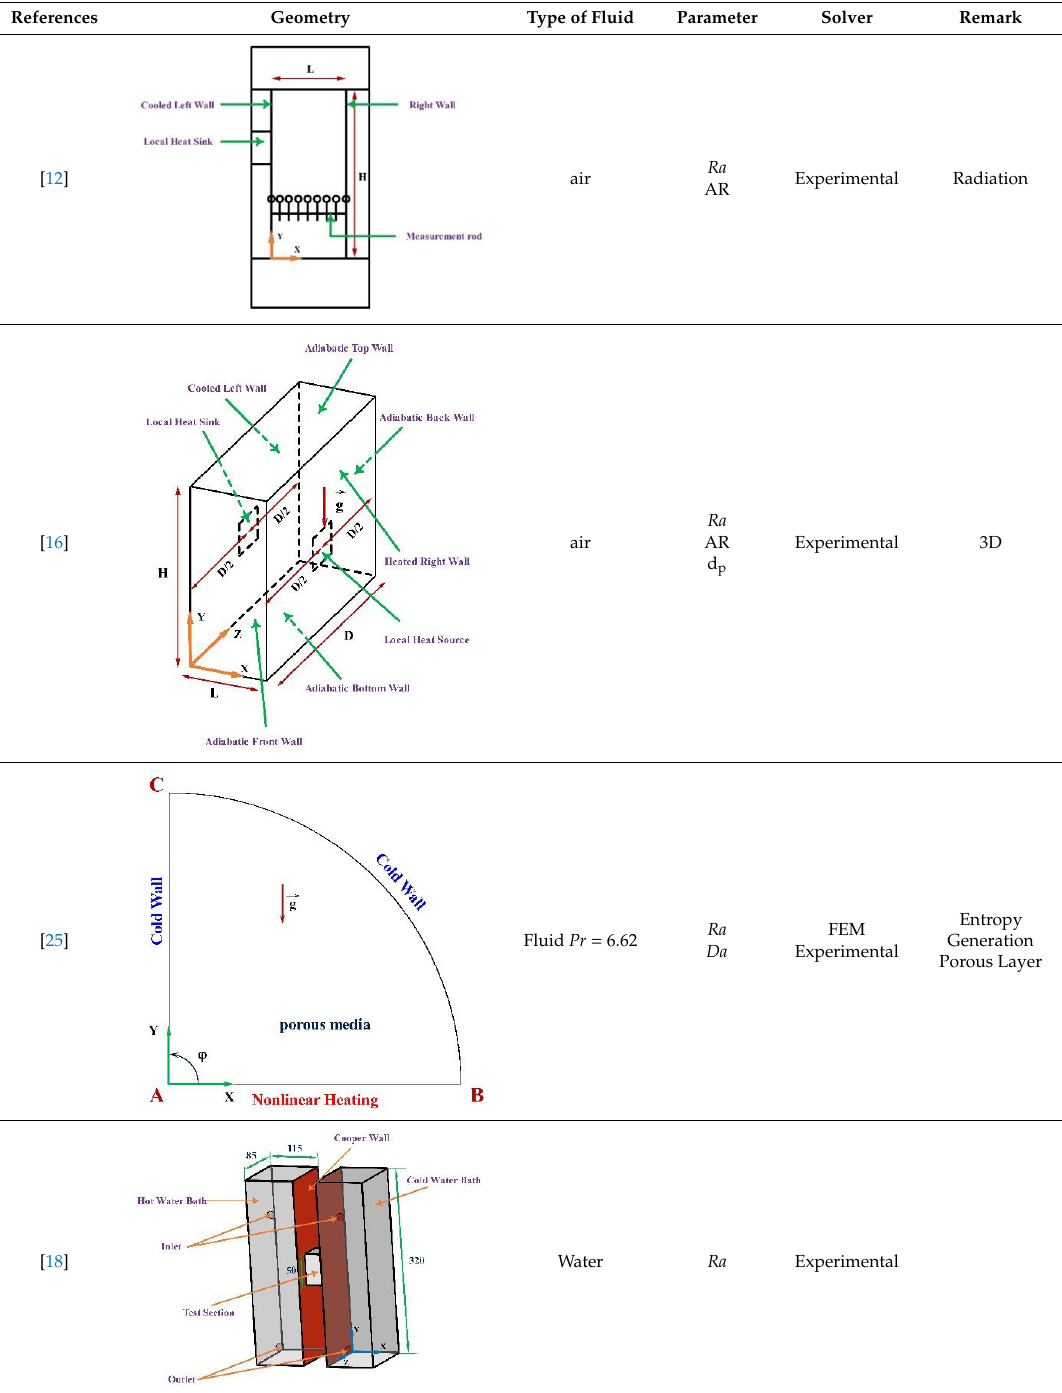
Table 1. Summary of experimental investigations performed on the